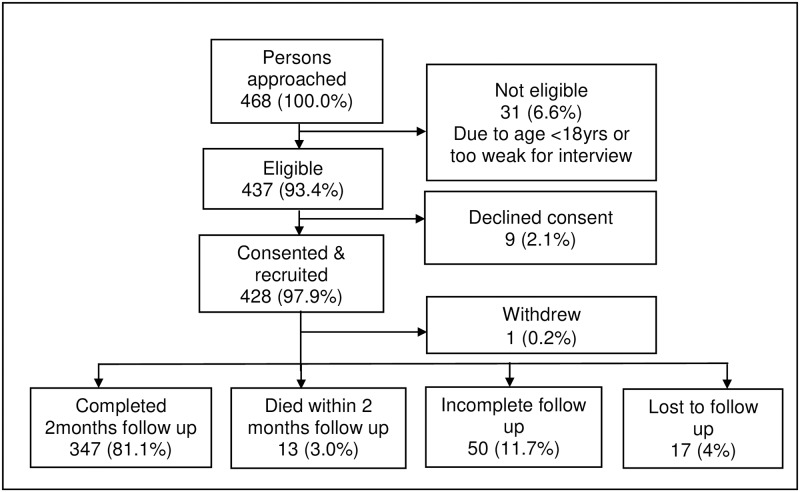
Flowchart of study recruitment and follow up of people requested to give sputum for TB investigation in Ketu South Municipality, Ghana.